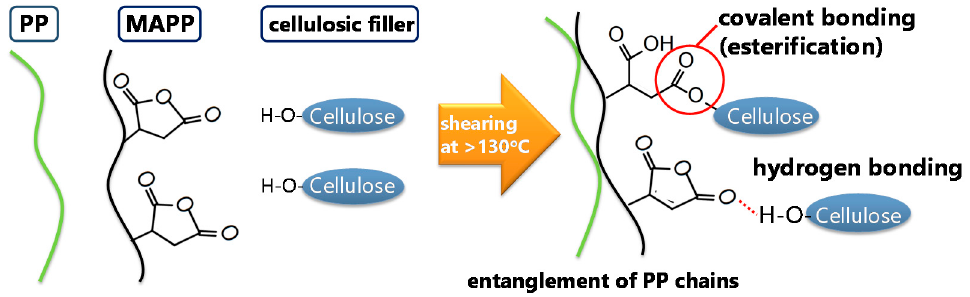
Figure 1. Functions of MAPP compatibilizers in cellulosic filler-reinforced PP composites.